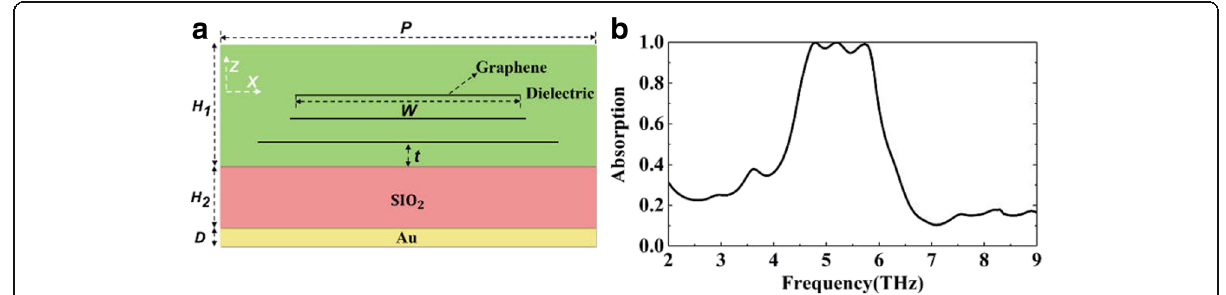
Fig. 4 a Schematic diagram of a three-layer graphene structure. b The calculated absorption spectra of three-layer graphene